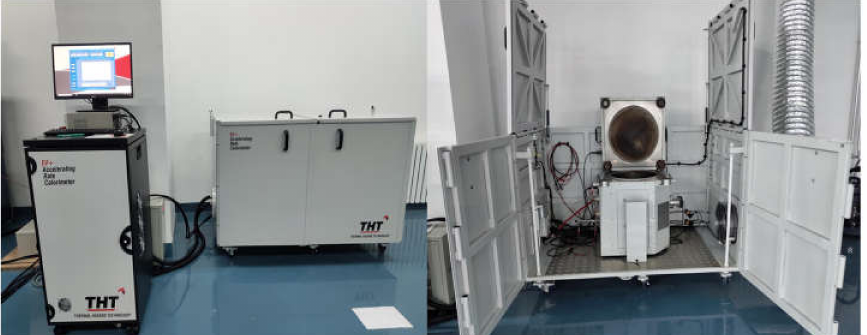
Figure 3. The experimental platform for charging and